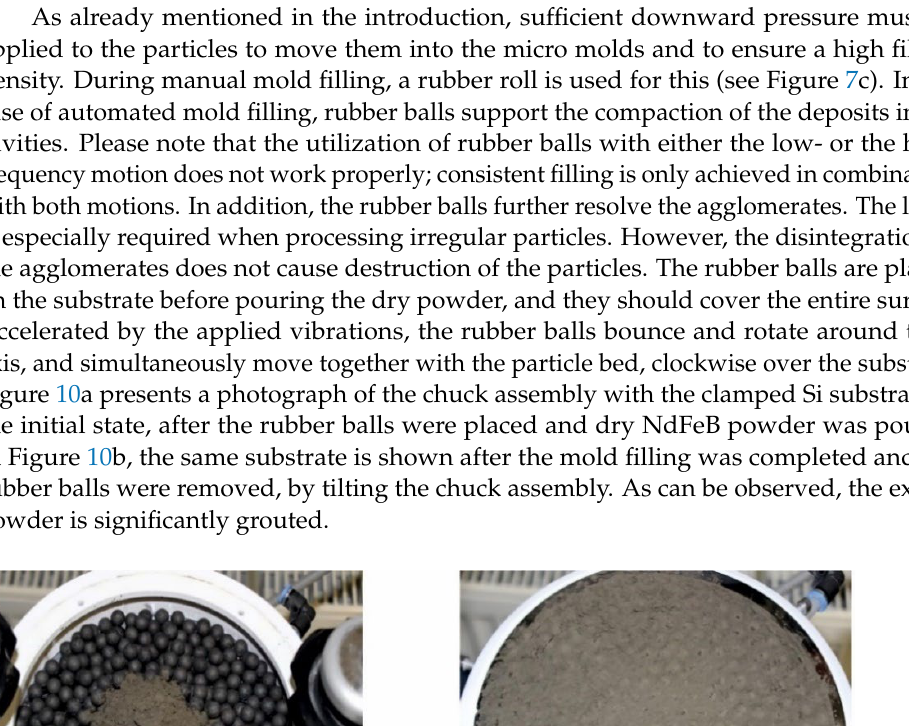
Figure 9. Photographs of the chuck assembly with mounted Si substrate ( a ) in the initial state after pouring of dry NdFeB powder within its center and ( b ) after completed mold filling.